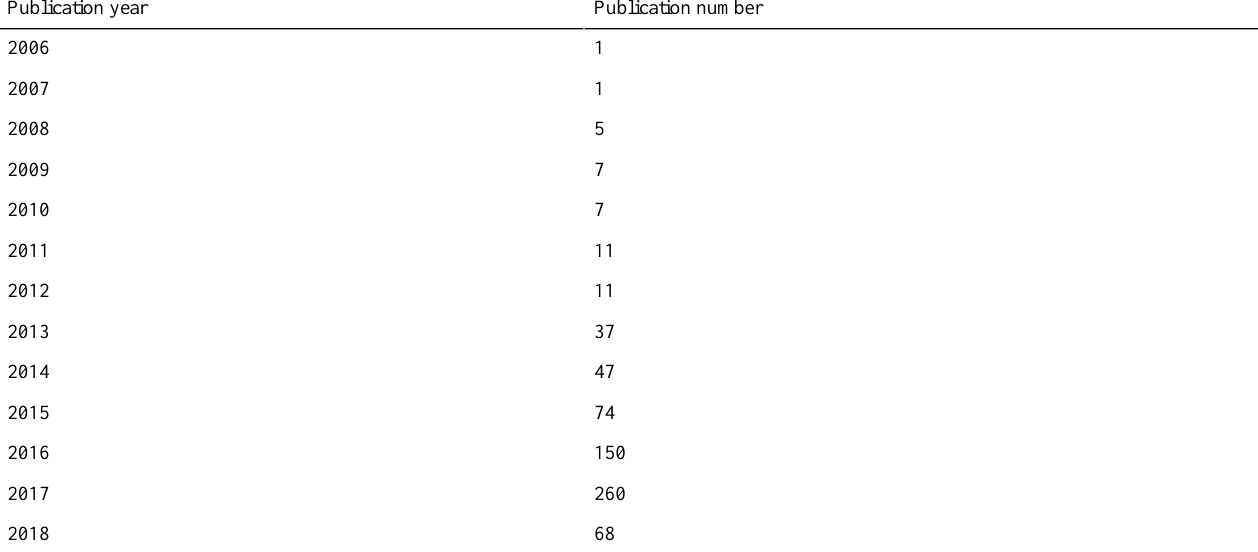
Table 2. The distribution of literature on immune-related adverse events by year (PubMed retrieve date: January 24,